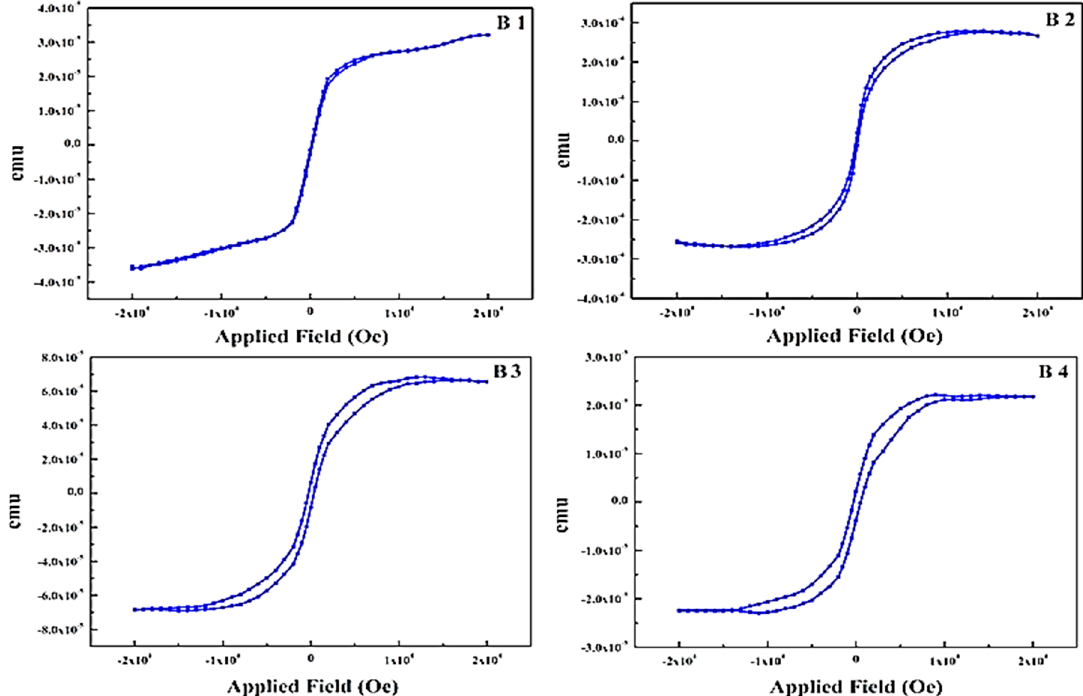
Figure 7. Magnetization measurements for FeN thin films at varying flow rates of N 2 . ( B1 ) N 2 flow rate = 40 sccm; ( B2 ) N 2 flow rate = 25 sccm; ( B3 ) N 2 flow rate = 20 sccm; and ( B4 ) N 2 flow rate = 10 sccm.